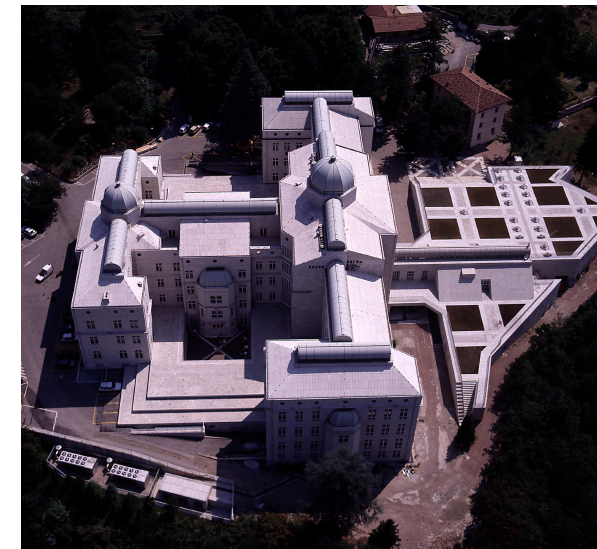
Figure 8: Aerial view of a complex building